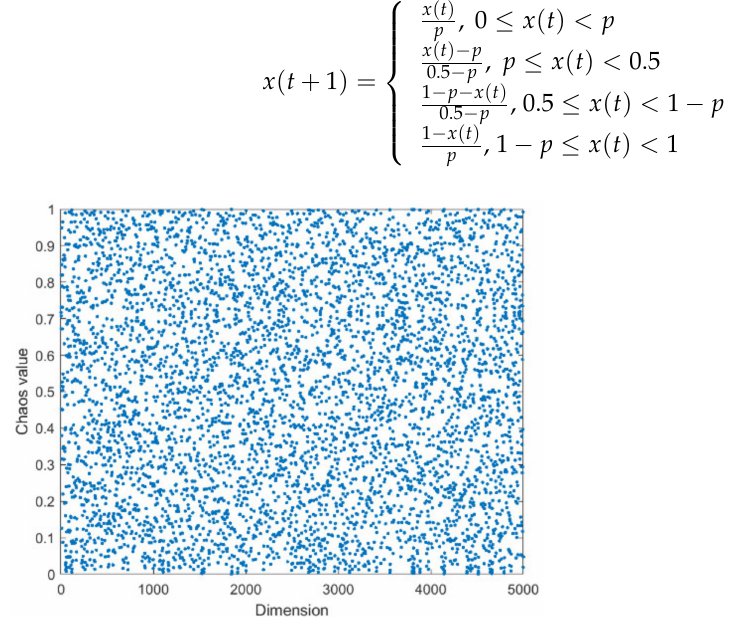
Figure 10. Random number distribution map generated by piecewise chaotic